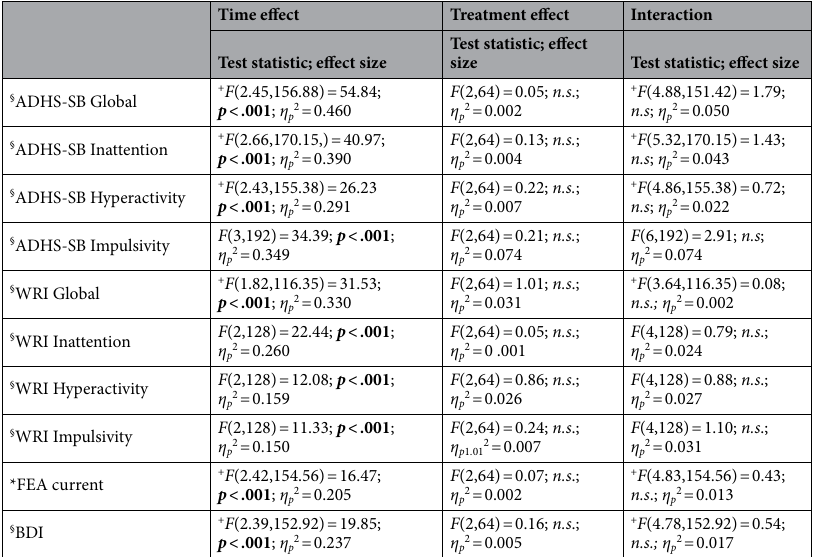
2 = 0.151) with fNIRS non-learners perceiving the therapist less competent as compared to fNIRS learners p